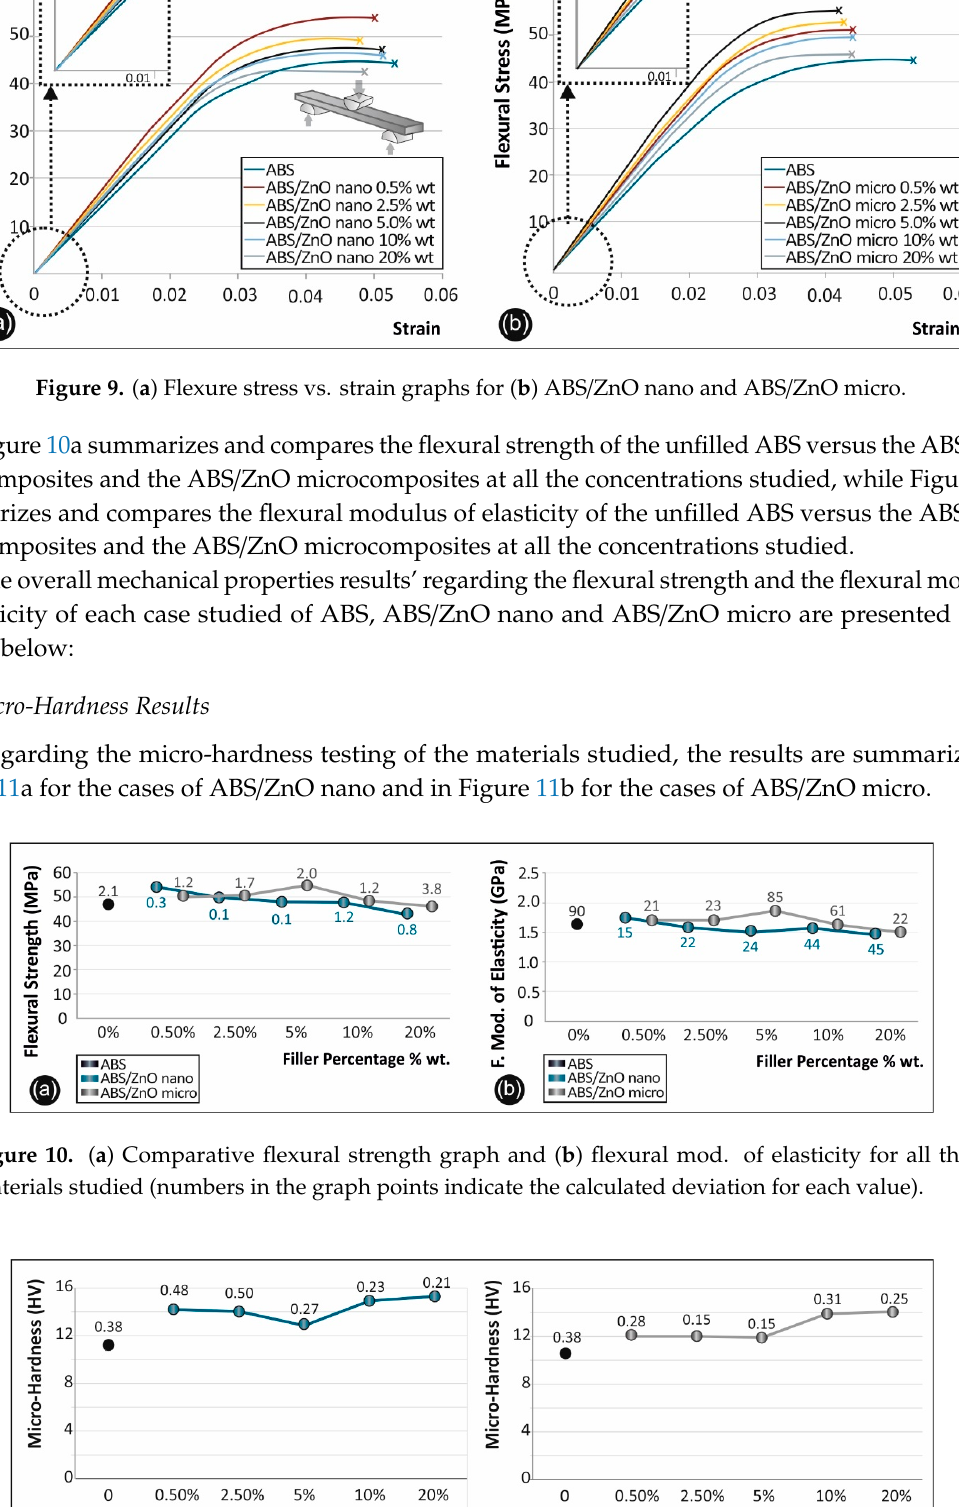
Table 2. Tensile and flexural properties and deviations of each material studied.